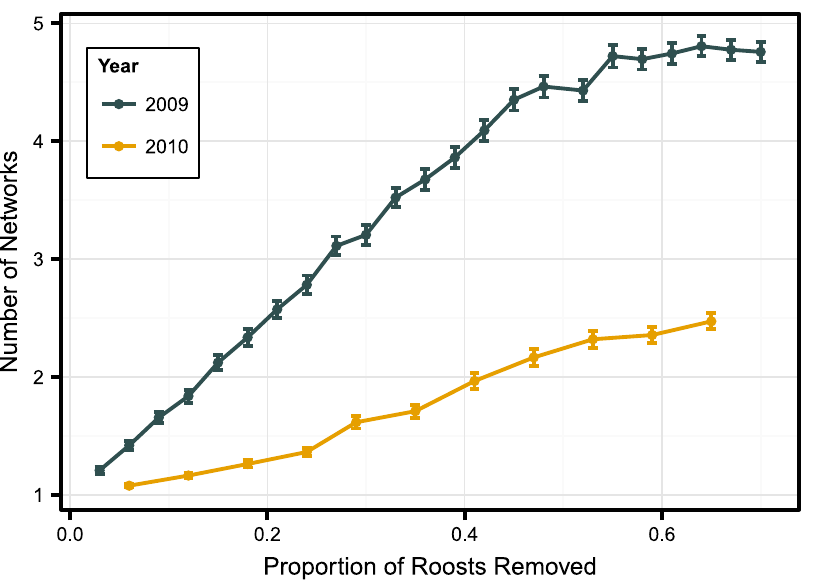
Figure 7. Roost removal impacts on Indiana bat ( Myotissodalis ) network fragmentation . Simulated effect of roost removal on the fragmentation of an Indiana bat maternity colony roost network in Pickaway County, Ohio, USA, 2009–2010. Random roost removal was performed 1,000 times per proportion of roosts removed; lines represent mean 6 standard error number of networks after node removal.